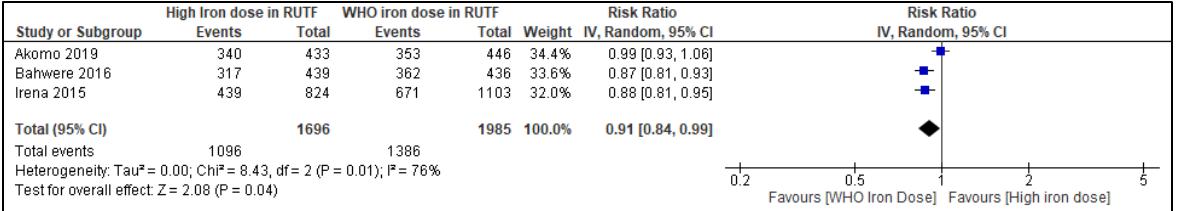
Figure 6. Effect of SMS-based RUTF with high iron content compared to peanut-based RUTF with WHO standard iron content on recovery from severe acute malnutrition. The forest plot shows pooled data from all three included studies from this review. Raw values were used, and an intention-to-treat analysis was preferred, where available. The pooled results show a potential decrease in recovery rates for children receiving RUTF with high iron content. Akomo 2019 [4]. has two study groups. We included data from milk-free soybean, maize and sorghum (FSMS) and a standard formulation